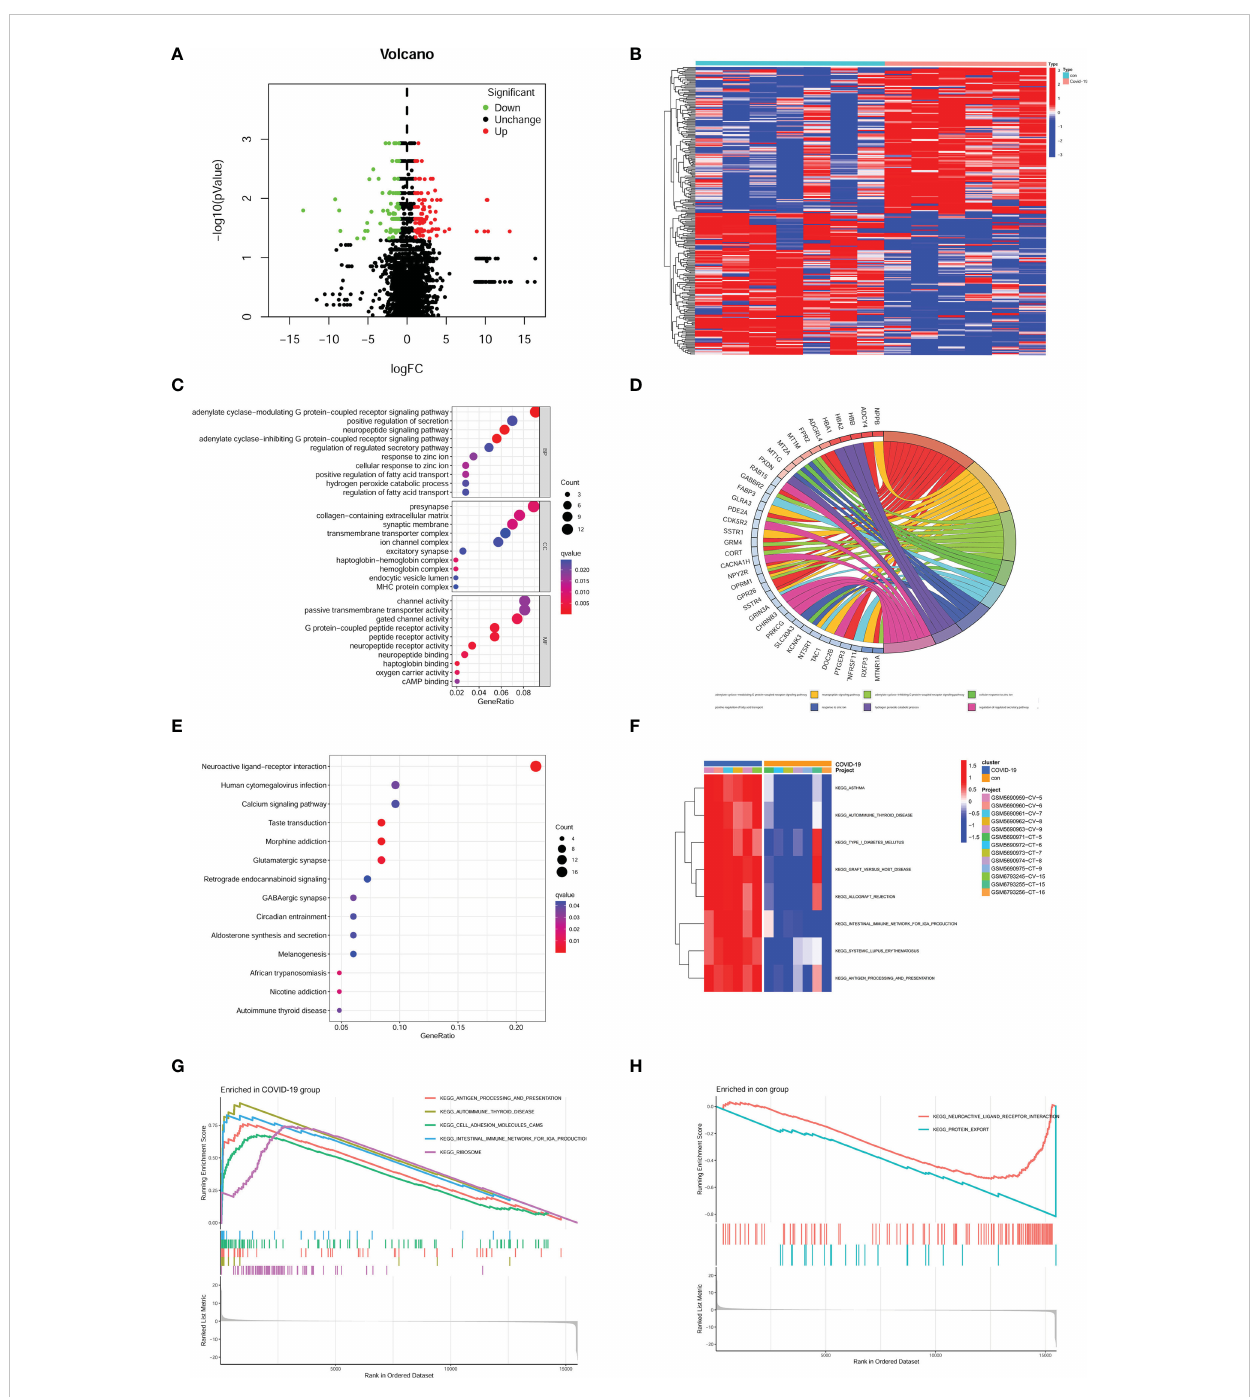
FIGURE 1 Identi fi cation of DEGs and enrichment analysis in the brain of COVID-19 patients. (A) Volcano plot of DEGs in GSE188847; Red plots, up-regulated genes; Green plots, down-regulated genes; Black plots, unchanged genes. (B) Heatmap of DEGs. (C) bubble plot of GO analysis. (D) According to the |logFC| the most relative genes were displayed. (E) bubble plot of KEGG analysis. (F) the result of GSVA analysis. (G) the result of GSEA analysis enriched in the COVID-19 group, (H) the result of GSEA analysis enriched in the con